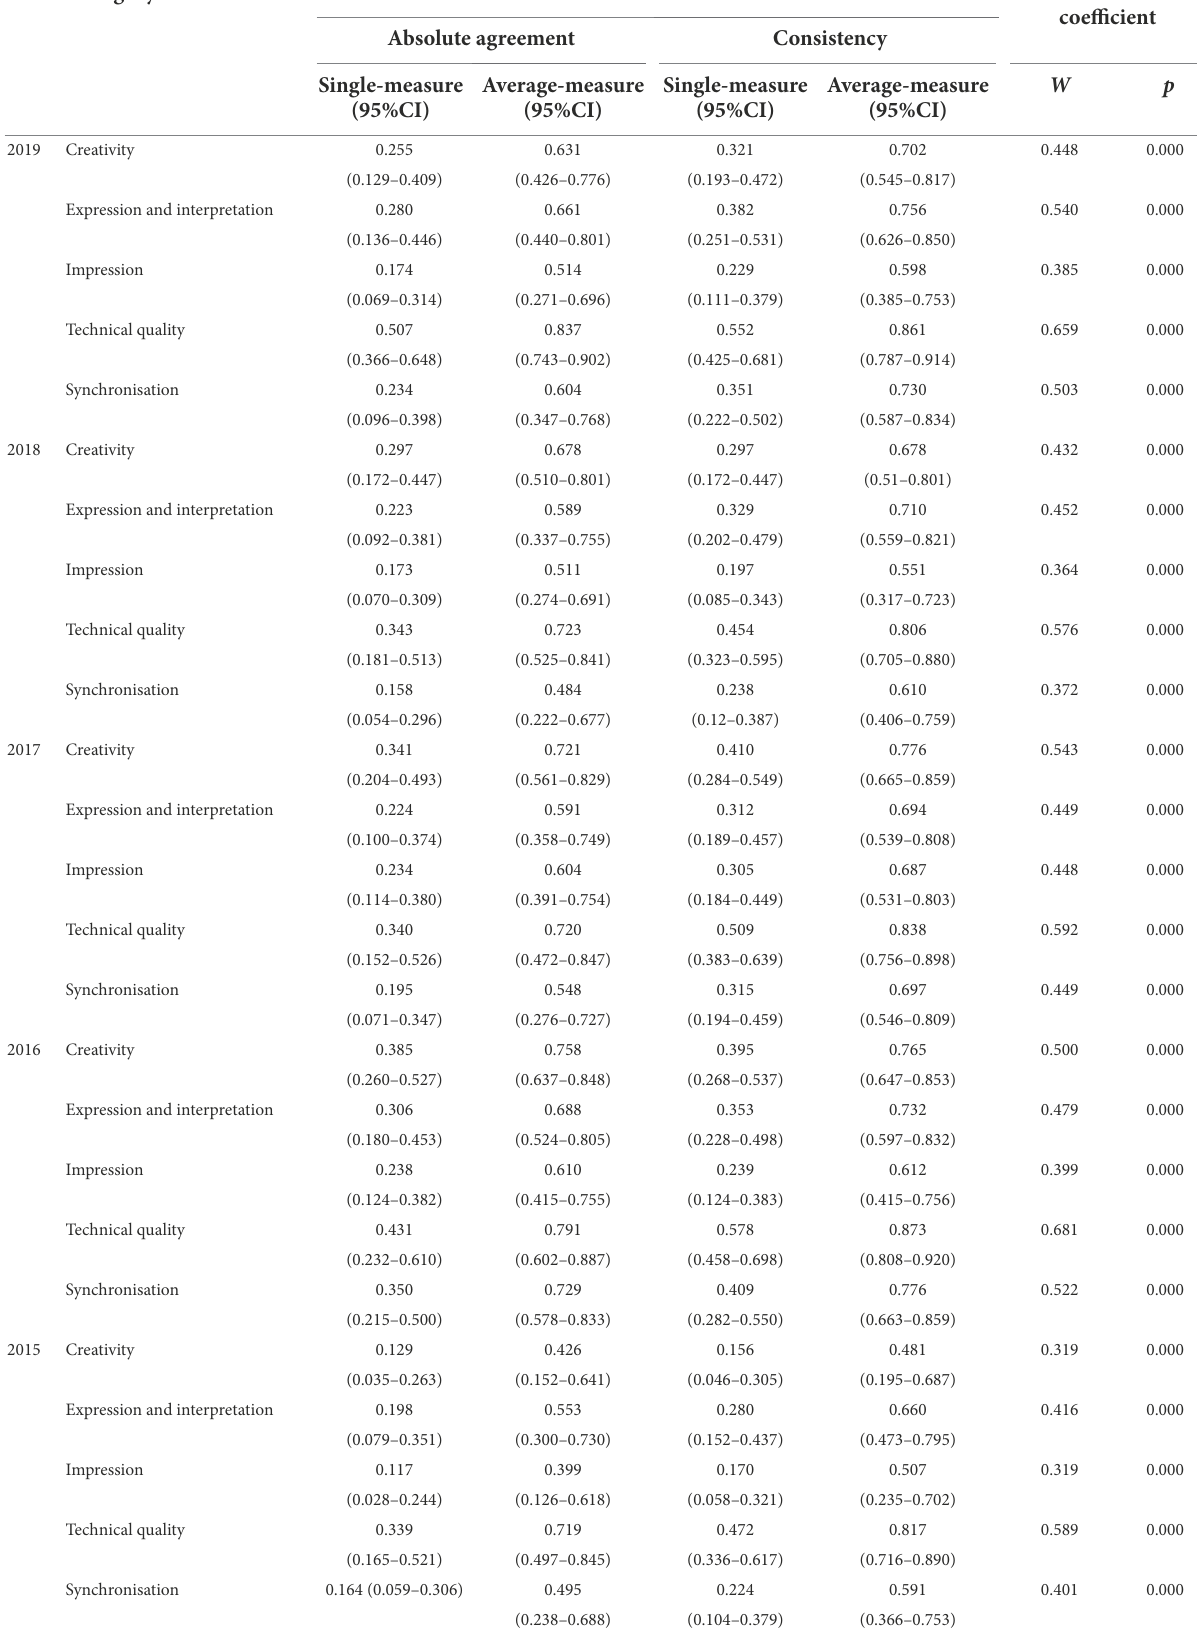
TABLE 5 Reliability for the five categories and the final score for the 2015–2019